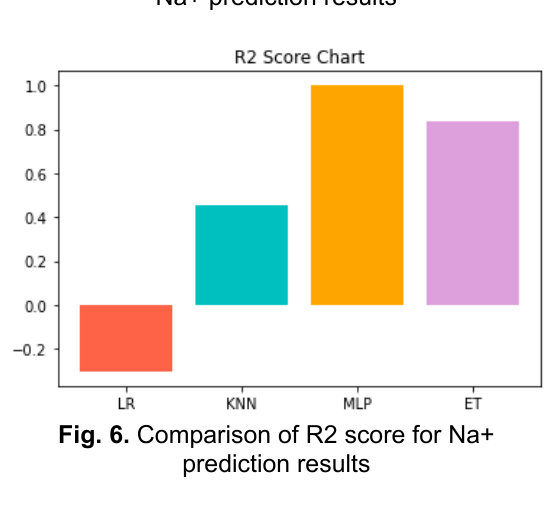
Fig. 5. Comparison of Kappa score for Na+ prediction results